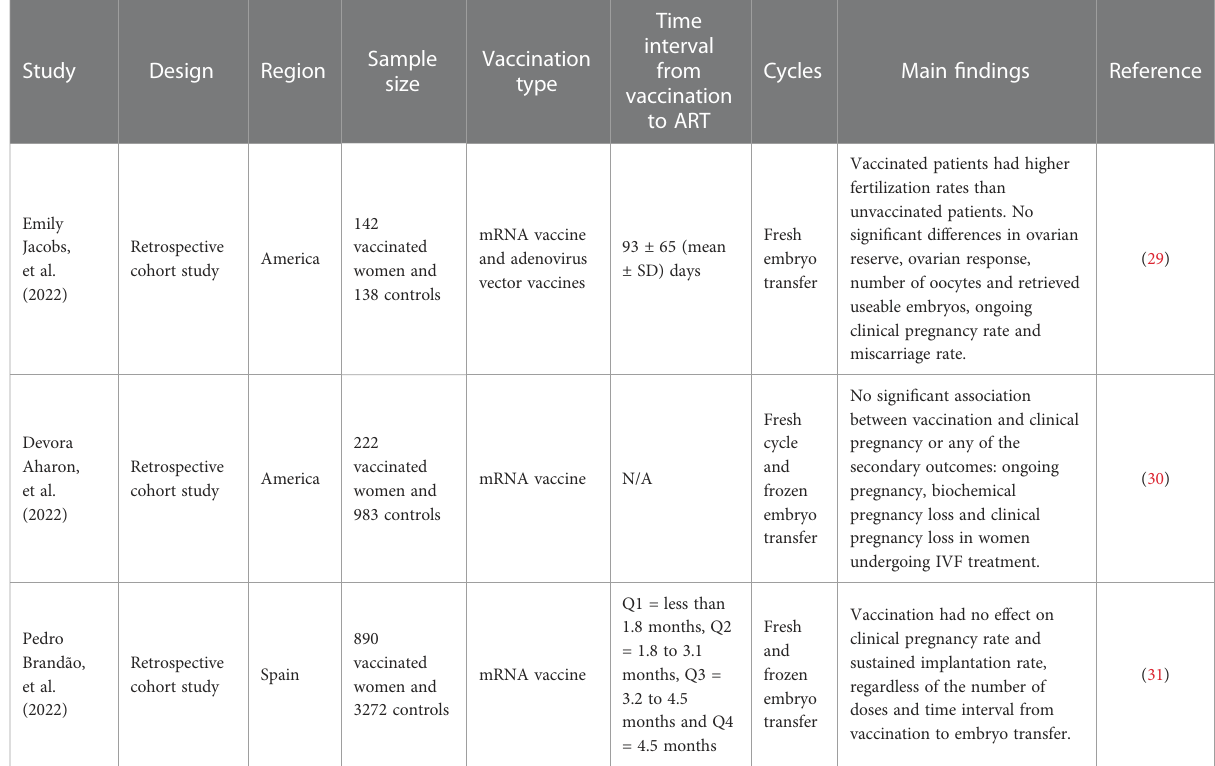
Vaccinated patients had higher fertilization rates